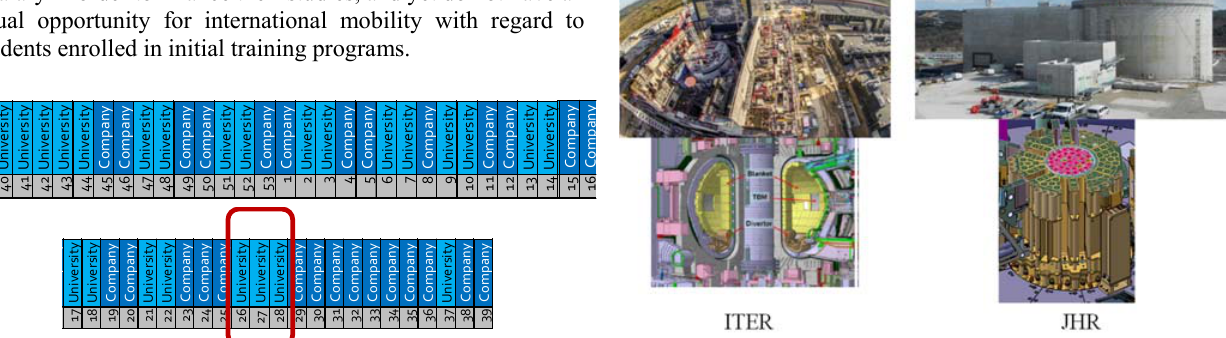
Fig. 2. Diagram of apprenticeship period schedule